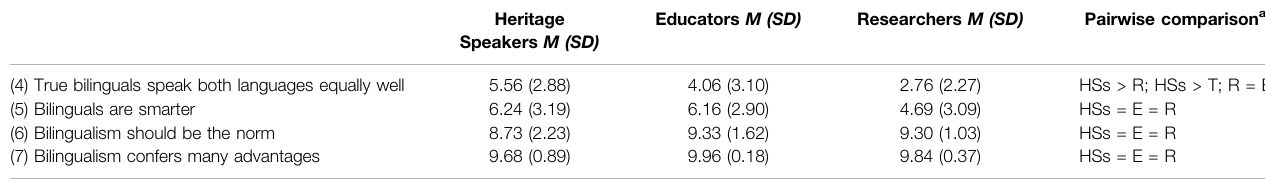
TABLE 1 | Summary of the responses for questions related to bilingualism for HSs, educators, and researchers.